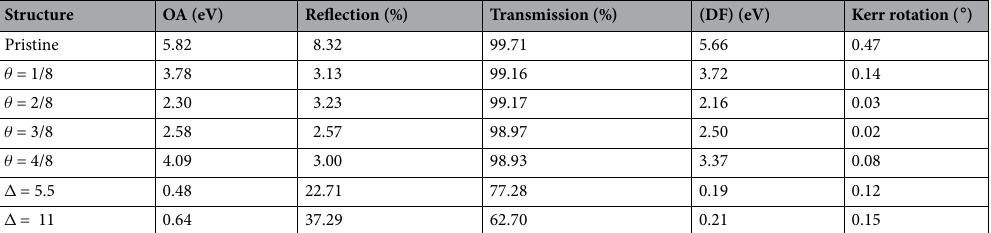
Table 3. First optical absorption peak (OA), maximum values of transmission and reflection, dielectric function peak (DF), and maximum value of Kerr rotation for the pristine hBN, different concentration of surface oxygen functionalization, and different levels of